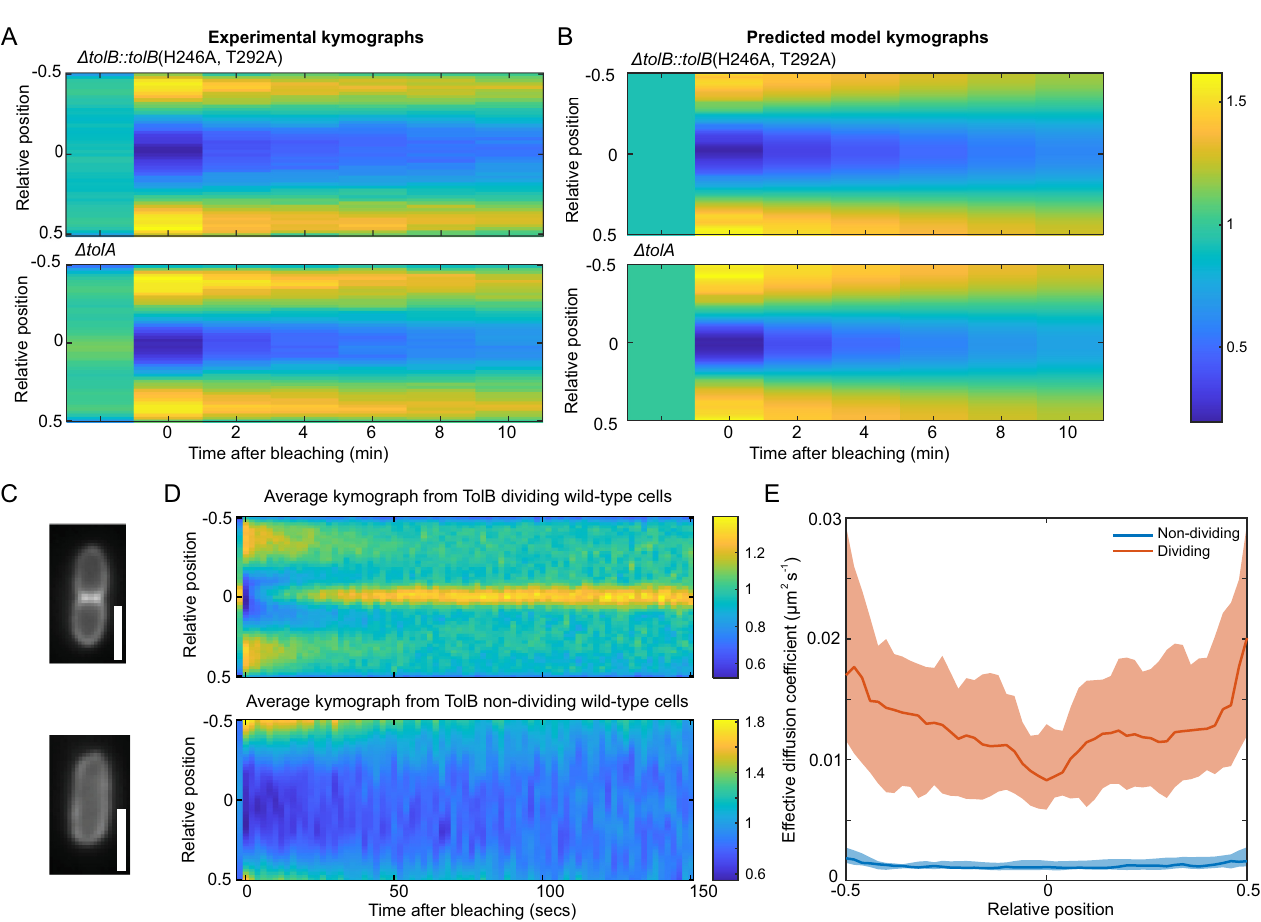
Fig 5. The model for the Tol-Pal system can predict the effects of mutants and TolB mobility. (A) Kymographs of FRAP of Pal-mCherry averaged over 30 Δ tolB :: tolB (H246A,T292A) (top) and Δ tolA (bottom) mutant cells. Data from reference [5]. (B) Predicted kymographs from the model using the fitting in Fig 4. See also S4 Fig. Colour bar is for both (A) and (B) and shows either the normalised fluorescence (experimental data) or normalised concentration (simulations). (C) Top, example cell showing the localisation of TolB-mCherry in dividing cells. Bottom, example cell showing the localisation of TolB-mCherry in non-dividing cells. In dividing cells, TolB is seen to be localised to the centre of the cells whereas in non-dividing cells it is homogeneously distributed, similarly to the distribution of Pal. Scale bar, 1 μ m. (D) Experimental FRAP kymographs of TolB-mCherry showing the average from 30 dividing (top) and non-dividing (bottom) cells. Colour bars show normalised fluorescence. (E) Effective diffusion coefficient of TolB-mCherry in individual non-dividing cells (blue line) and dividing cells (orange line). In dividing cells, the diffusion coefficient is higher than in non-dividing cells. Based on the model, most TolB in dividing cells is in the outer periplasm whereas in non-dividing the majority is in the inner periplasm. This suggests that the diffusion coefficient of TolB in the outer periplasm is faster than that of TolB in the inner periplasm. Shown is the median of approximately 30 cells as a function of relative long axis position with 95% confidence